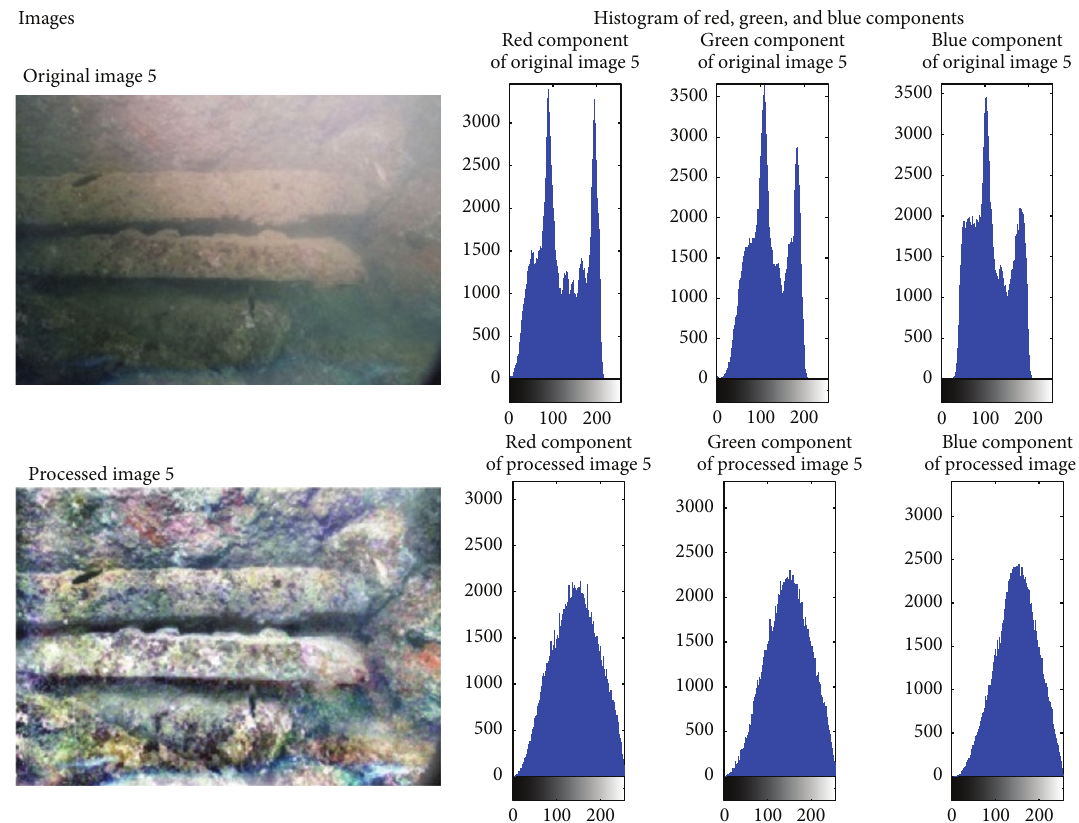
Figure 3: Original and processed images with their histogram for three color components (Original Image Courtesy NIO, Goa,